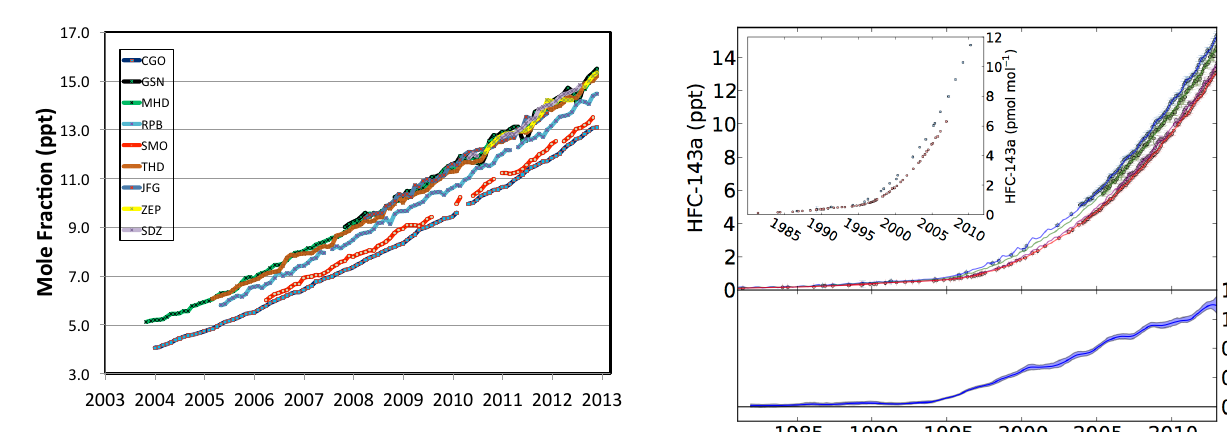
Figure 1. Baseline monthly mean HFC-143a mole fractions (ppt) from in situ Medusa GC-MS measurements at AGAGE stations: Cape Grim Observatory (CGO), Gosan (GSN), Mace Head (MHD), Ragged Point (RPB), Samoa (SMO), Trinidad Head (THD), Jungfraujoch (JFG), Zeppelin (ZEP) and Shangdianzi (SDZ).